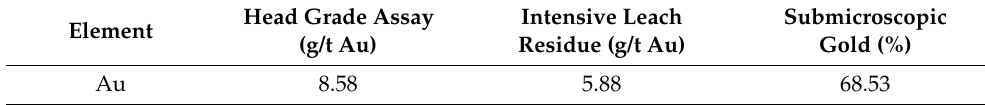
Table 7. Residue fire assay